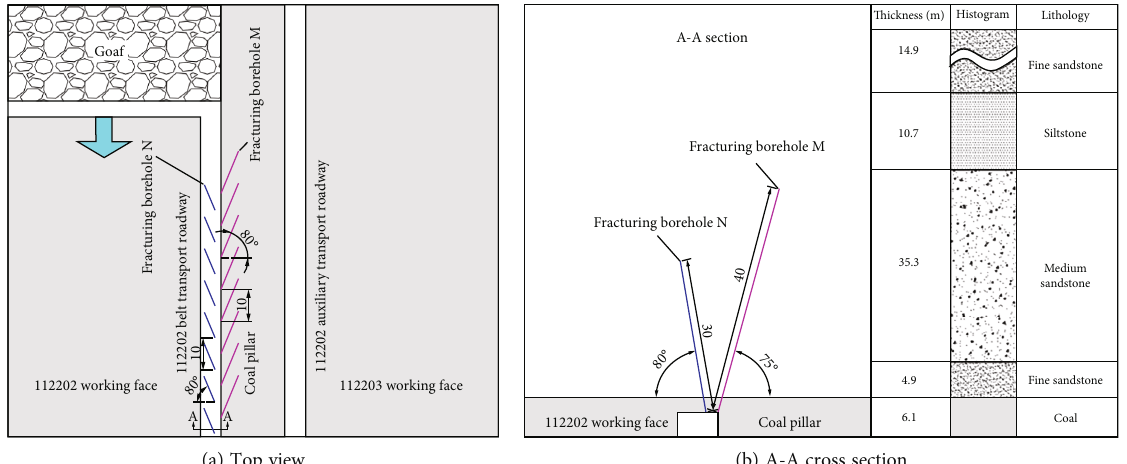
Figure 13: Layout plan of hydraulic fracturing